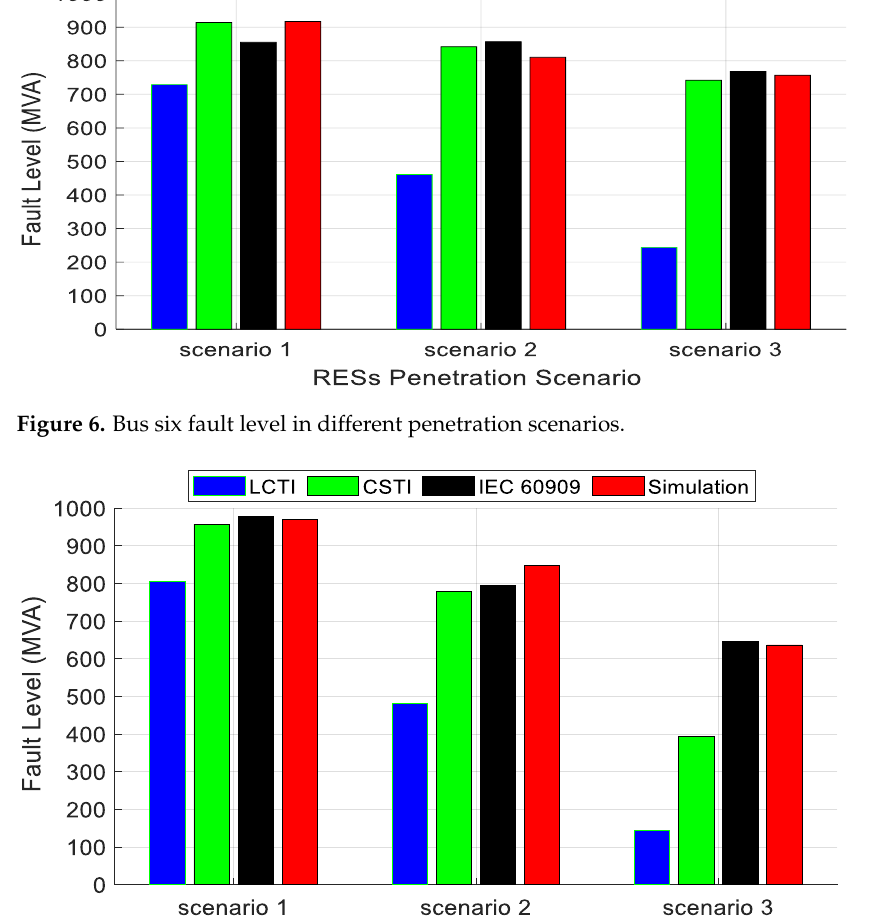
Figure 7. Bus eight fault level in different penetration scenarios.